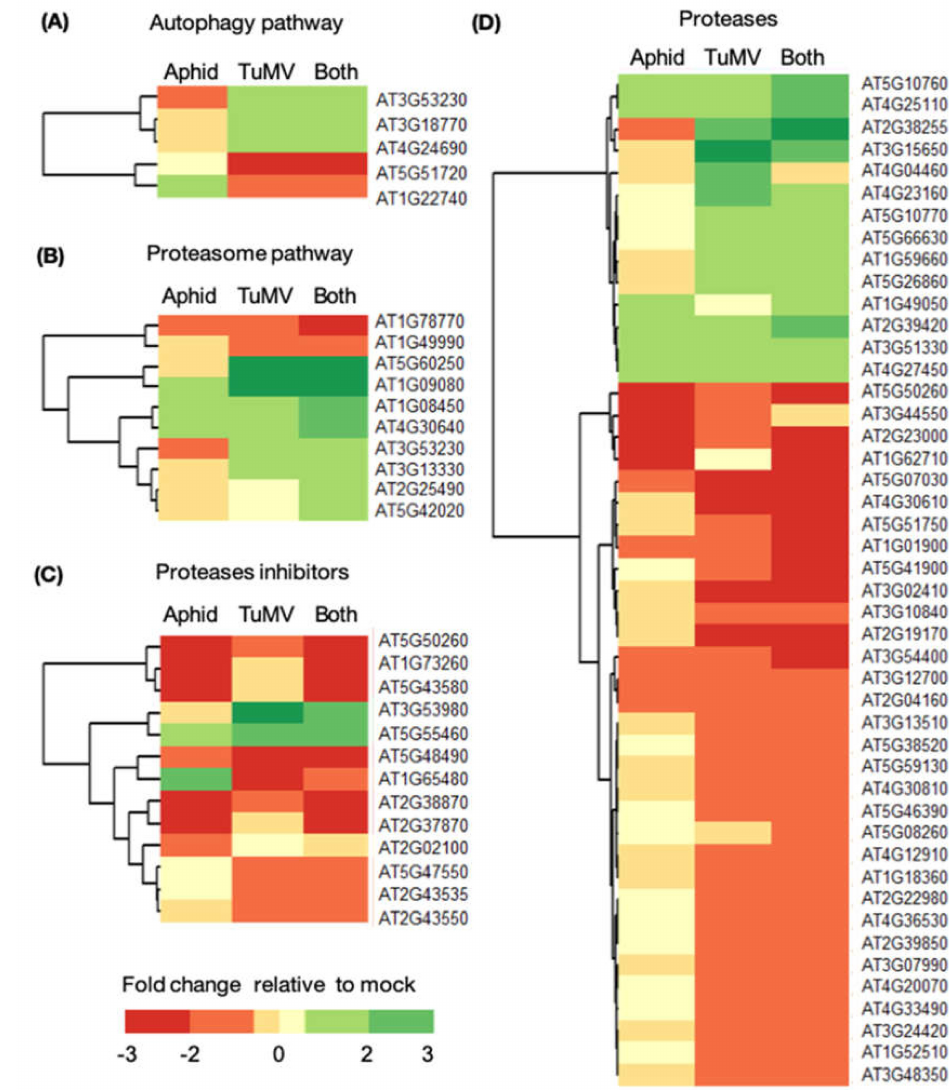
Figure 3. TuMV infection and aphid feeding significantly impacts protein degradation pathways in A. thaliana . RNA-seq was performed with mock-inoculated A. thaliana , A. thaliana one week after TuMV infection (TuMV), A. thaliana 48 h after infestation with the Myzus persicae aphid (Aphid), a vector of TuMV, or from plants with both treatments (Both). Each sample represented a pool of two plants and three samples were taken per treatment (N = 3, 6 plants total). Heatmaps show genes that where at least 1.5 times differentially expressed relative to mock ( p -value < 0.1). Differ- entially expressed genes were grouped according to the following protein degradation